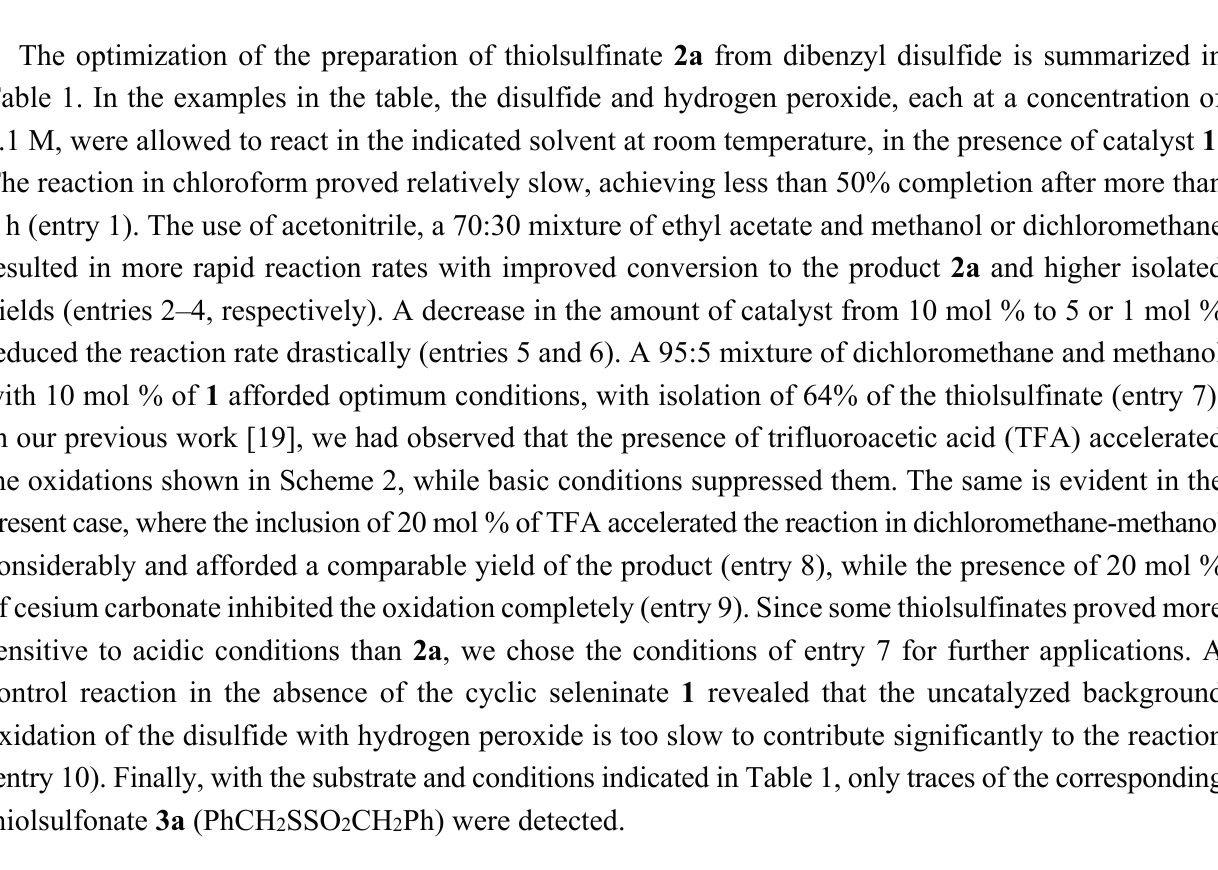
Table 1. Optimization of conditions for the synthesis of thiolsulfinate 2a a